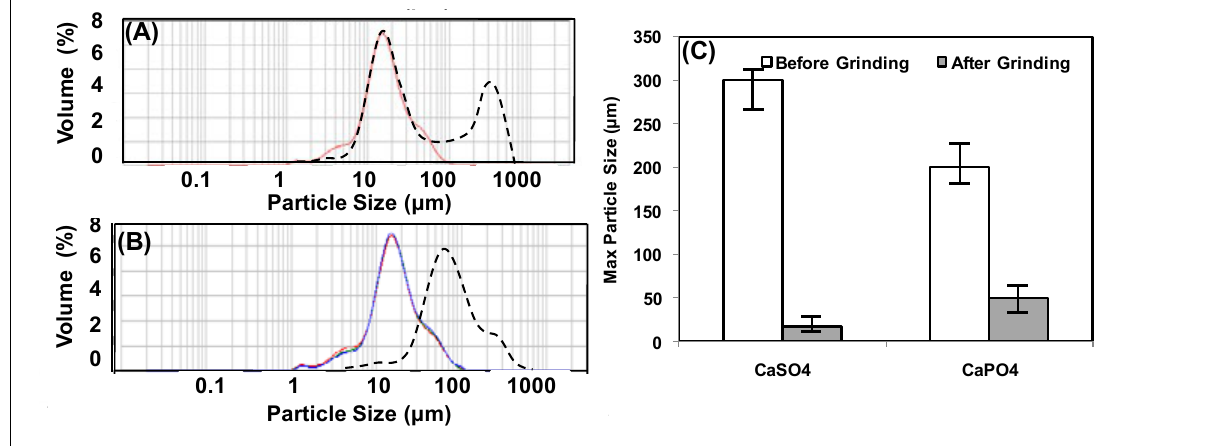
Figure 3. Particle size distribution of (A) calcium sulphate and (B) calcium phosphate. (C) Maximum particle size of calcium sulphate and calcium phosphate particles. The dashed lines in (A) and (B) are the particle size distributions before grinding.